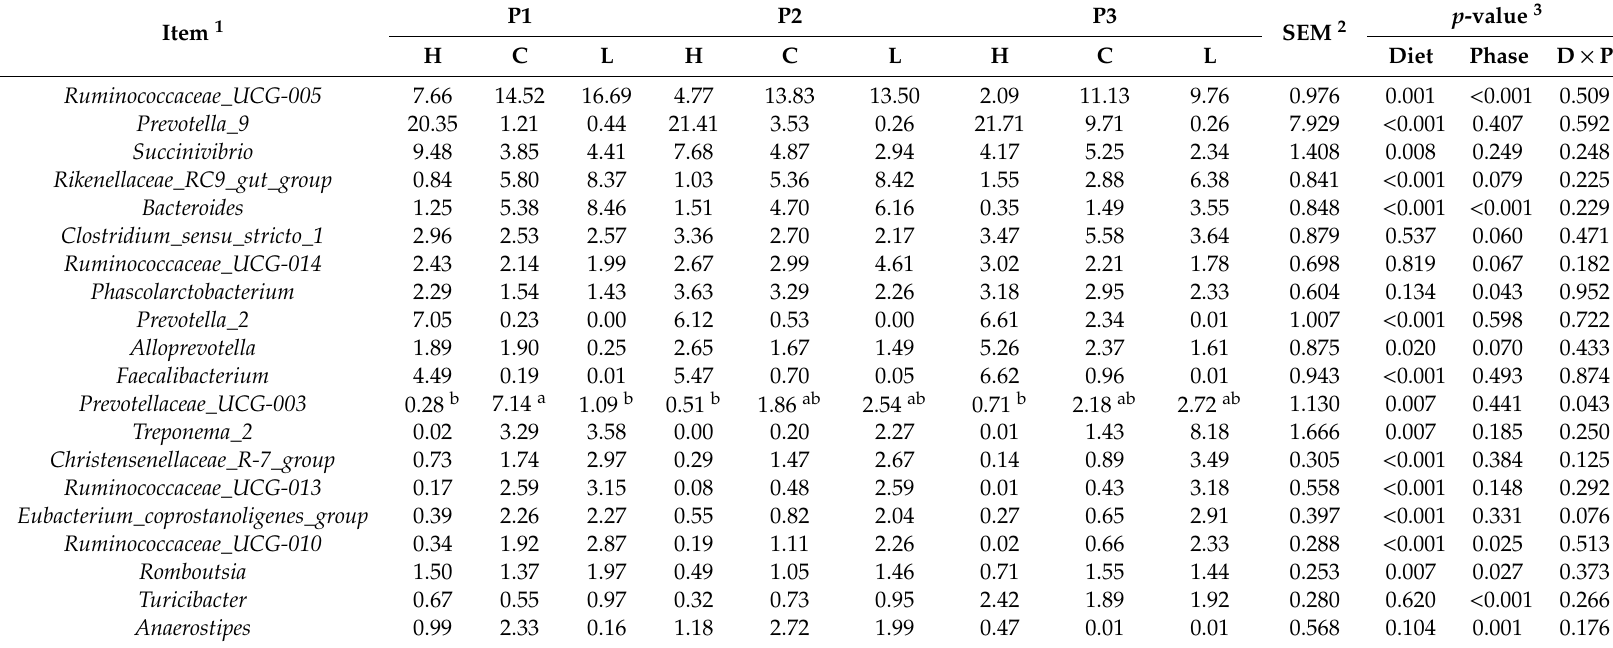
Table 4. Fecal Genus (Relative Abundance > 1%) Composition of Holstein Steers Fed with Three Stepwise Density